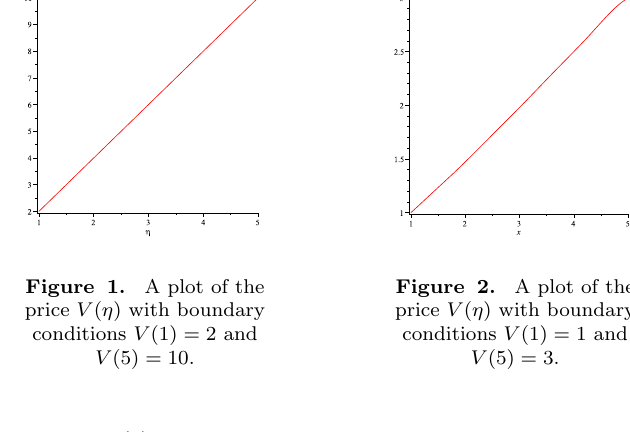
Table 1. Values of V ( η ) for different values of V c , V d with c = 1, d =